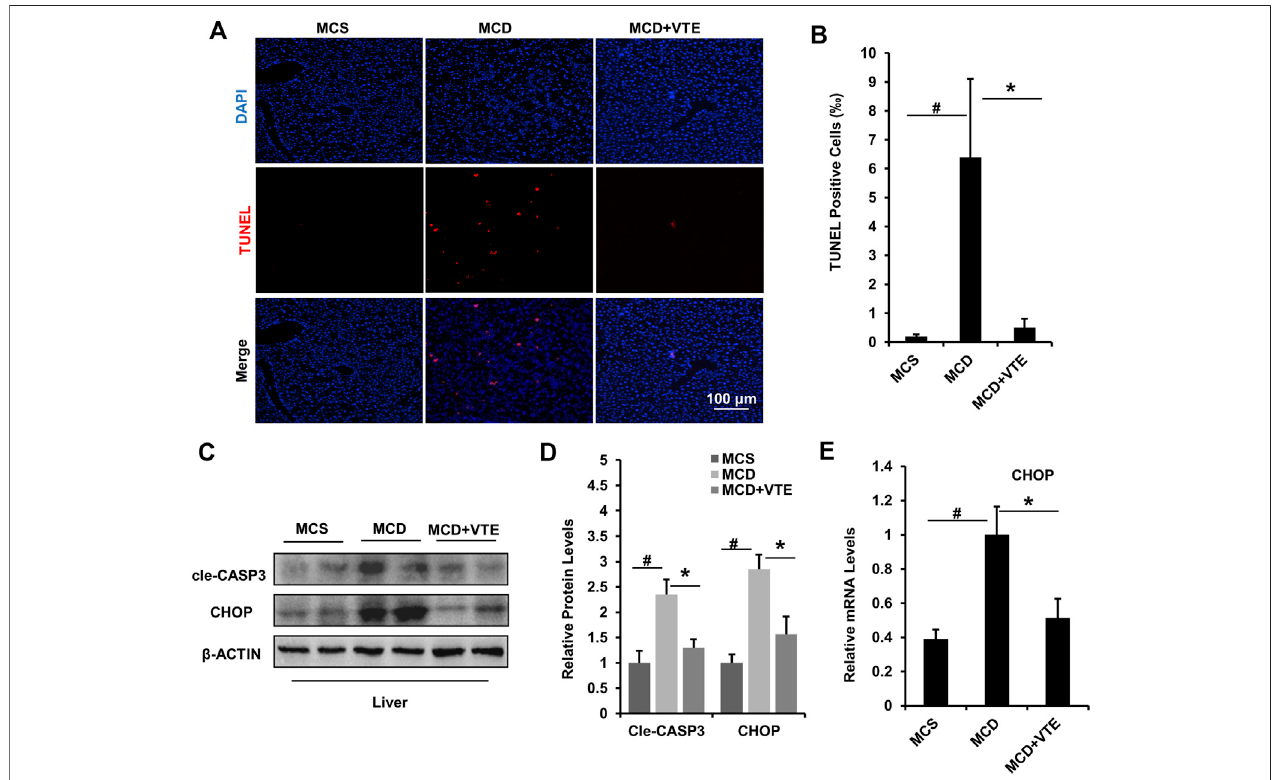
FIGURE 5 | VTE relieves apoptosis and ER stress in the livers of MCD-induced mice. Male C57BL/6J mice (20 ± 2 g) were fed an MCD diet in the presence and absence ofVTE (1 g100 g − 1 diet) for 6 weeks (A) TUNEL staining in thelivers from the MCS diet-, MCD diet-,and MCD + VTE-fed mice. Scale bars, 100 μ m (B) TUNEL positive cells ( ‰ ). Data are statistically analysed as means ± SEM ( n (cid:2) 6 per group) (C, D) Protein levels of cle-CASP3 and CHOP in mice were analysed by immunoblotting. The relative protein level was shown (E) The relative mRNA expression of CHOP in mouse liver. β -ACTIN was used as an internal control for normalizing the mRNA levels and protein levels. n (cid:2) 5 for all groups. # p < 0.05, MCD compared with the MCS group. * p < 0.05. MCD compared with the MCD + VTE